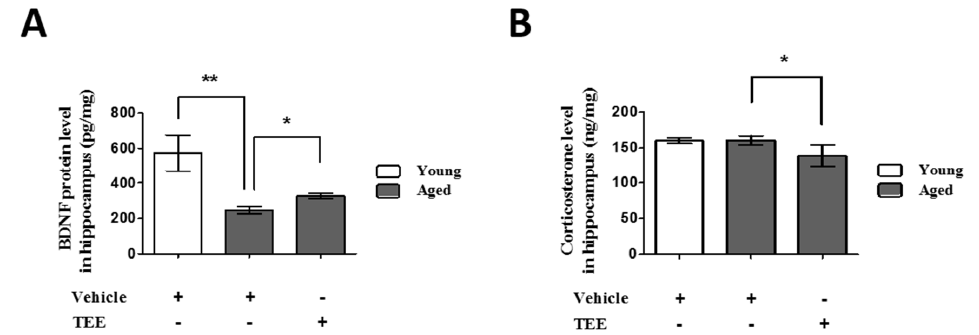
Figure 4. Oral administration of TEE decreased corticosterone and increased brain ‐ derived neurotrophic factor (BDNF) in in aged hippocampus. The corticosterone ( A ) and BDNF ( B ) levels in